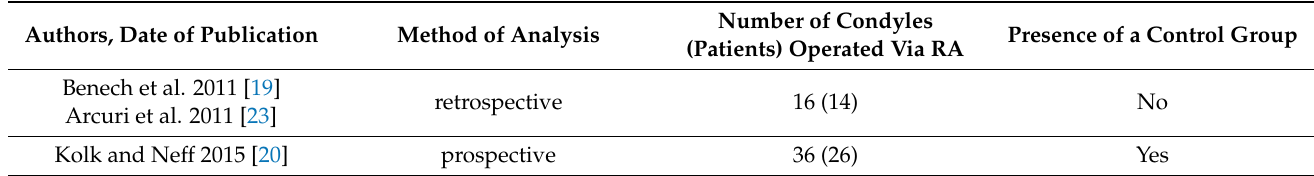
Table 2. Information on the type of studies analyzed.